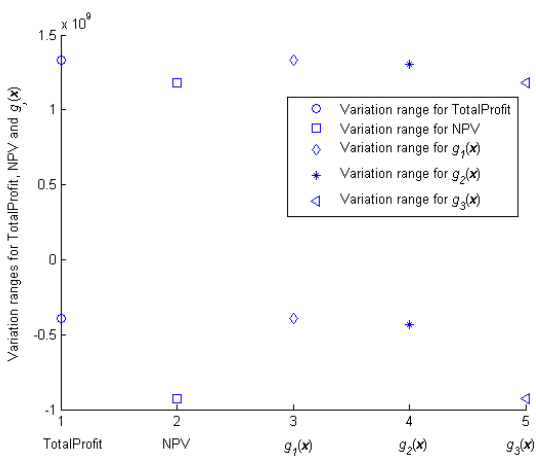
Figure 2. Variation ranges of total profit (TotalProfit: USD), net present value (NPV: USD), and y j = g j ( x ) due to economic and technical